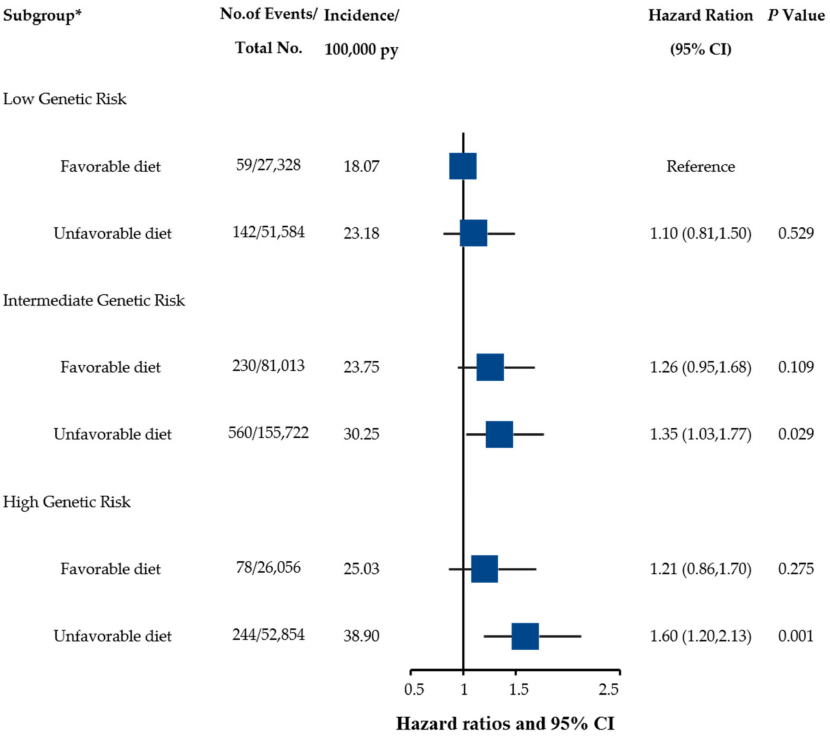
Figure 2. Risk of incident UGI cancer according to healthy diet and genetic risk categories in the UKB cohort. The HRs were estimated using Cox proportional hazard models with adjustment for age at recruitment, sex, assessment center (10 regions), ethnicity, Townsend deprivation index, education, BMI, glycosylated hemoglobin (HbA1c), smoking status, alcohol intake frequency, physical activity, multimorbidity, family history of cancer, and the first 10 principal components of ancestry. * For healthy diet and genetic risk on UGI cancer risk across and within genetic risk group analysis, participants without available genetic information were excluded ( n = 21,032). Unfavorable diet (healthy diet score < 4) and Favorable diet (healthy diet score ≥